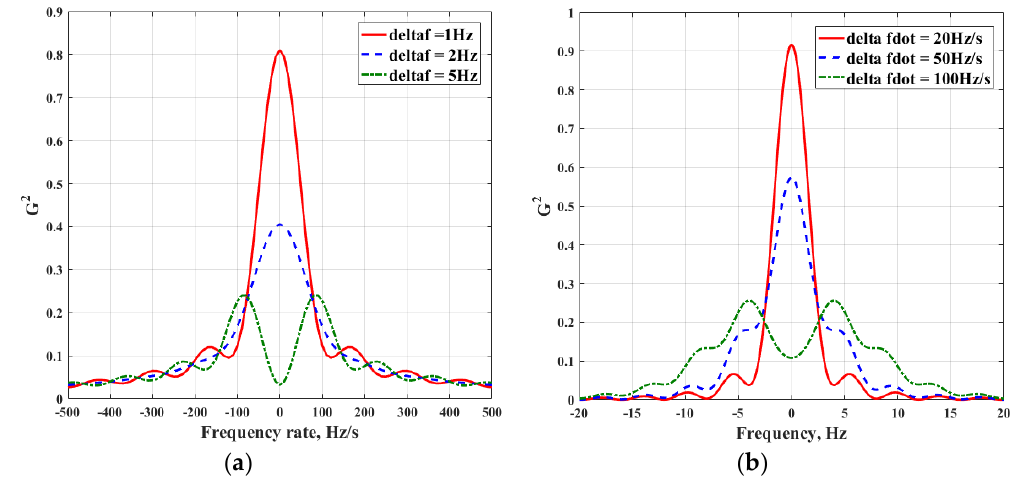
Figure 16. Effect of Doppler dynamic errors on the coherent integration: ( a ) Doppler frequency error; ( b ) Doppler rate error.